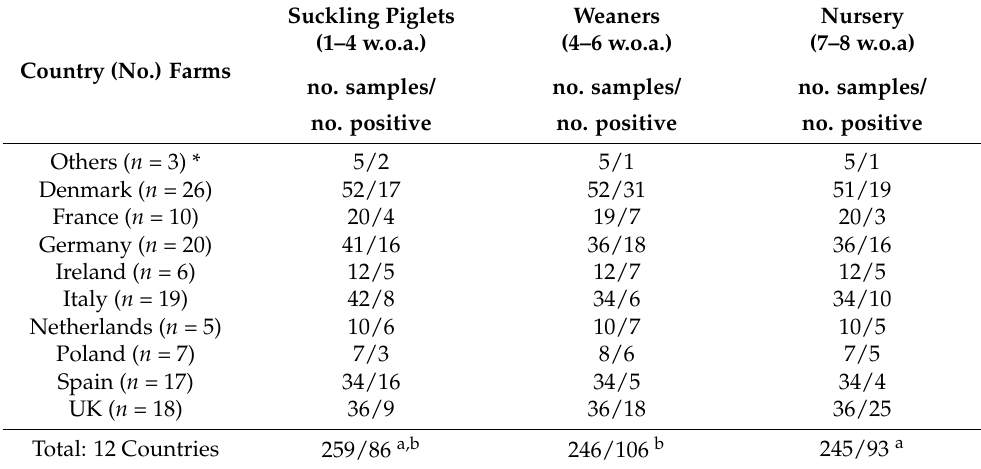
Table 2. Detection of IAV by rRT-PCR on a sample level in the different countries and sampled age